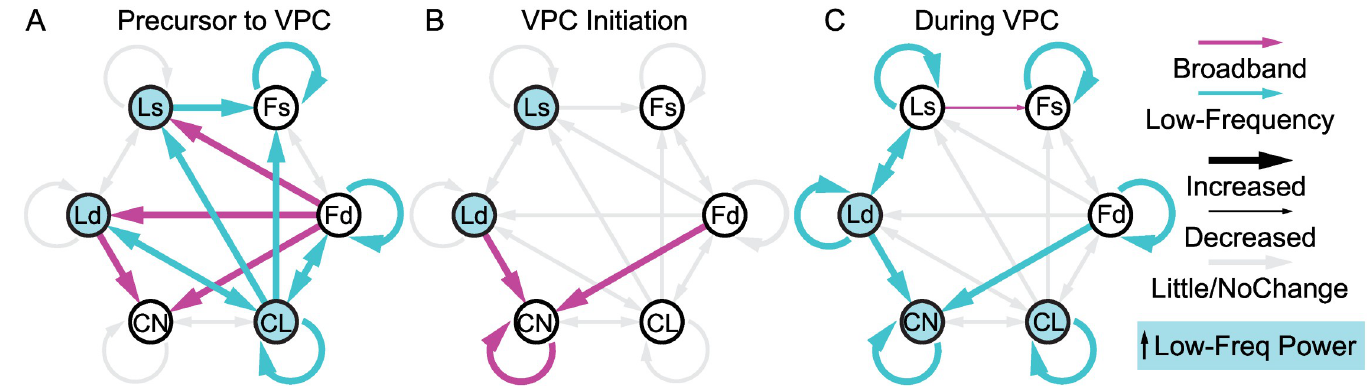
Fig 13. Neural correlates of VPC involve substantial impairment of communication in thalamo-cortical and cortico-striatal circuits. A - C , Connection diagrams summarizing key coherence and power patterns within and between different areas ( A ) just before, ( B ) at onset, and ( C ) ongoing during VPC. Arrows show increased (thicker) or decreased (thinner) coherence between specified areas at lower (light blue) or broadband (pink) frequencies. Light gray arrows indicate pathways where coherence changes are relatively small or unchanged. Blue shading in areas shows power increases at low frequencies. Ls and Ld, superficial and deep layers of LIP; Fs and Fd, superficial and deep layers of FEF; CN, caudate nucleus; CL, central lateral thalamus. Diagrams summarize results from Figs 9–11, and values thresholded at .4 in Fig 12.